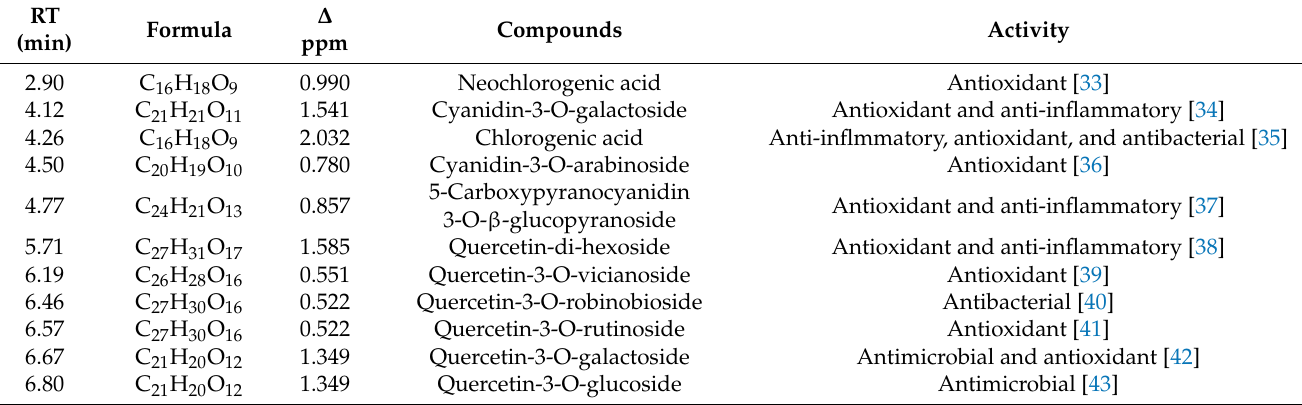
Table 4. The major bioactive compounds in FAME identified by LC–MS/MS